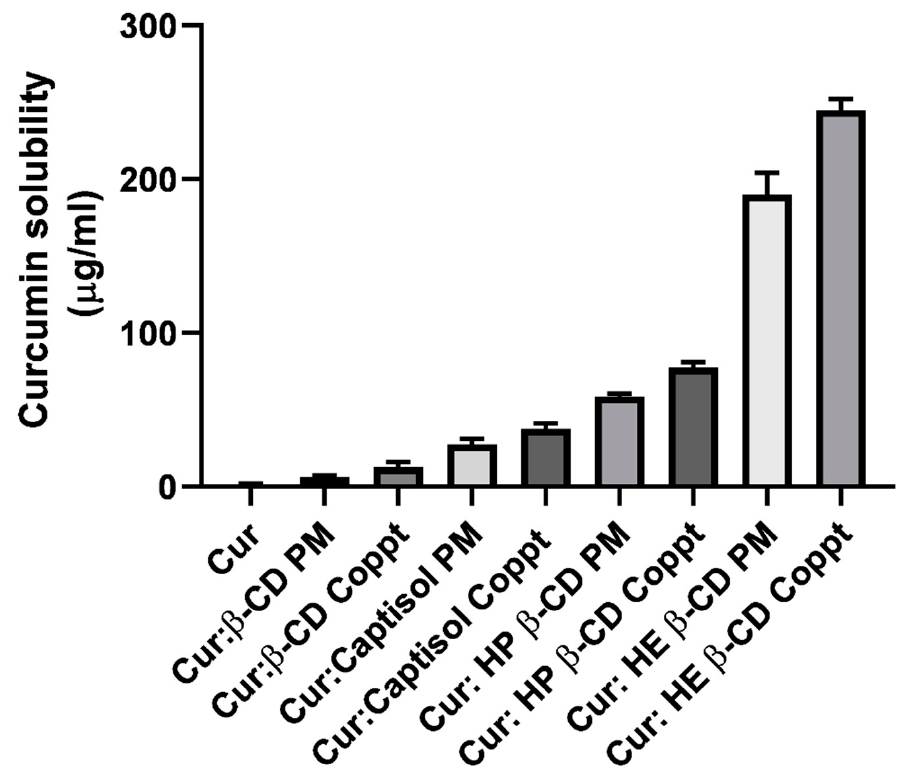
Figure 2. Equilibrium solubility of curcumin, curcumin: β -cyclodextrin, curcumin: Captisol,